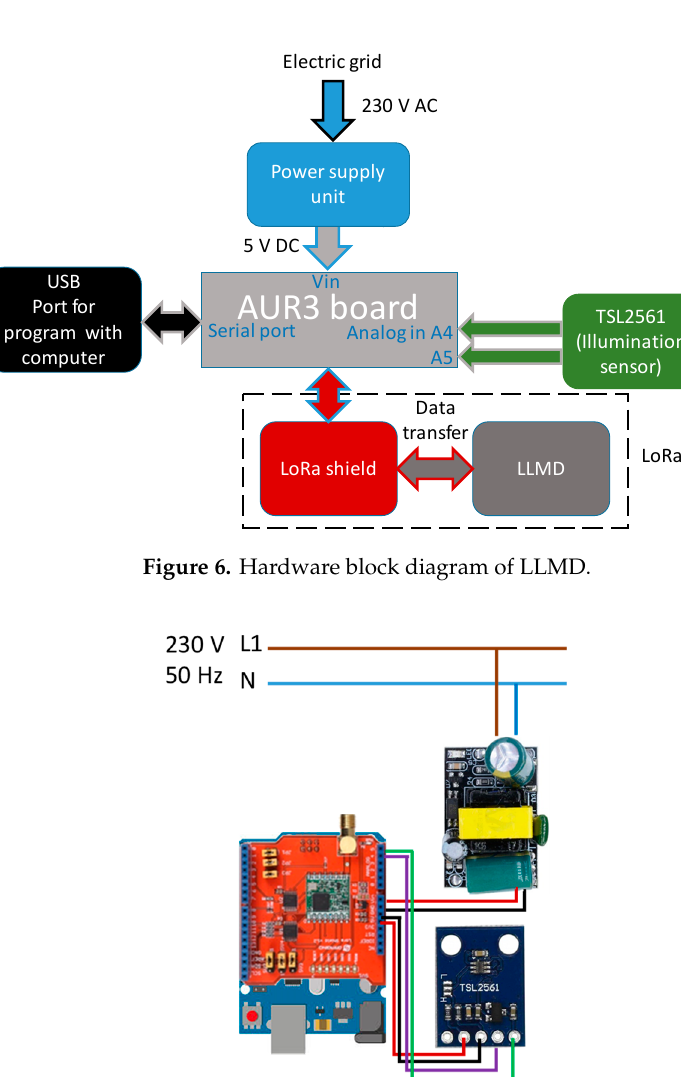
Figure 7. Wiring diagram of LLMD.